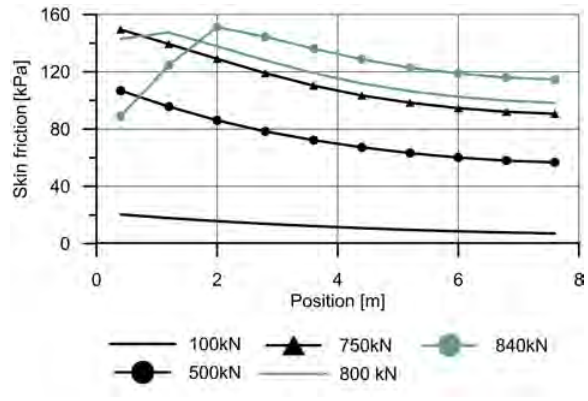
Figure 13. Skin friction distributions.